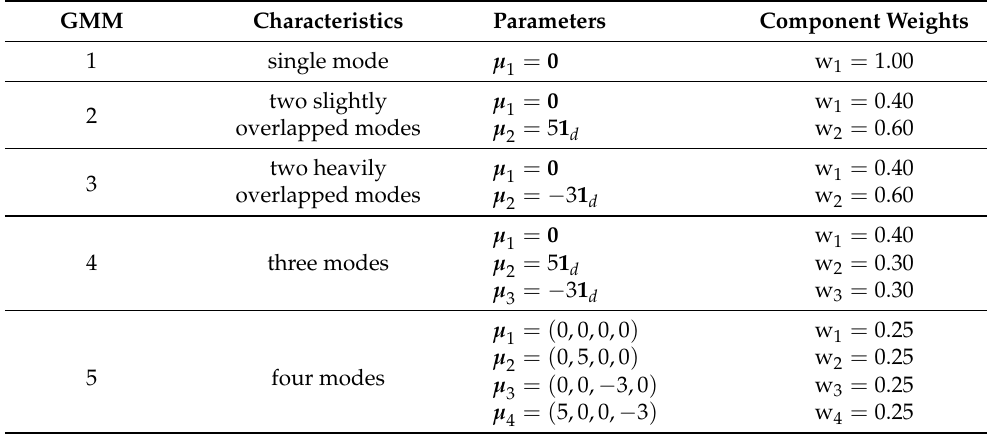
Table 1. Parameters for GMM